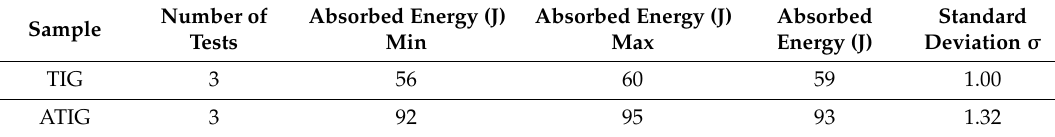
Table 10. Mesurments of energy absorbed and standards deviation of TIG and ATIG (optimal flux) at HAZ.